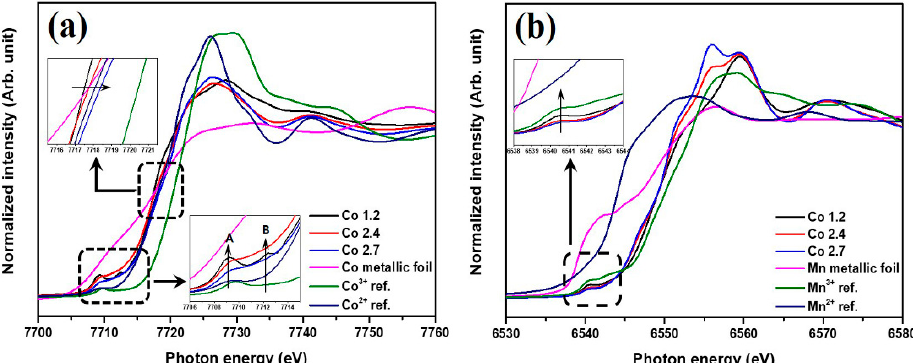
Figure 5. X-ray absorption near edge structure (XANES) ( a ) Co K-edge and ( b ) Mn K-edge spectra of Co- and Mn-based the mixed phase Co- and Mn-based the mixed phase materials.